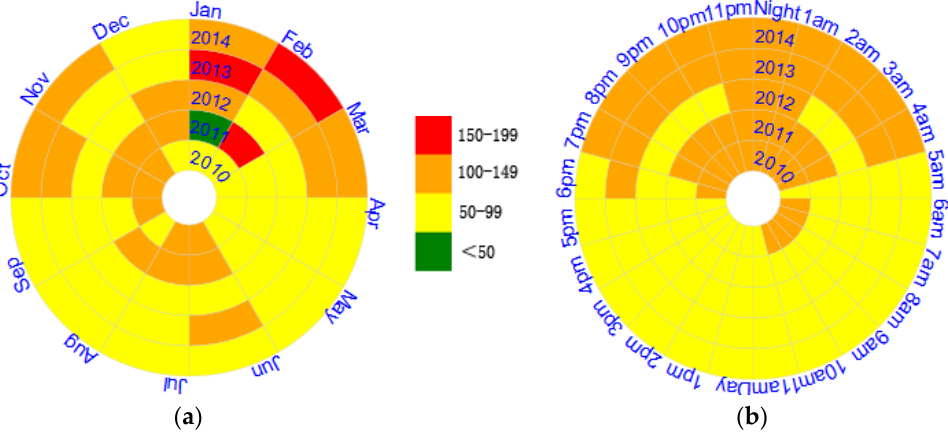
Figure 9. Circular heat maps from 2010 to 2014 are selected: ( a ) year and month circular heat map showing the monthly air pollution concentration; and ( b ) year and hour circular heat map showing the daily air pollution concentration.